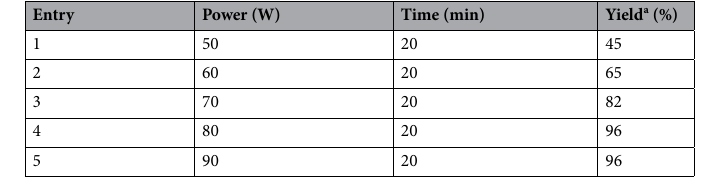
Table 2. Optimization of reaction condition for the formation of 2-amino-4H-chromenes. Reactions conditions: p-chloro benzaldehyde (1 mmol), malononitrile (1 mmol), 1,5-dinaphtol compound (0.5 mmol), nano KCC-1@NH 2 (5%). a Isolated